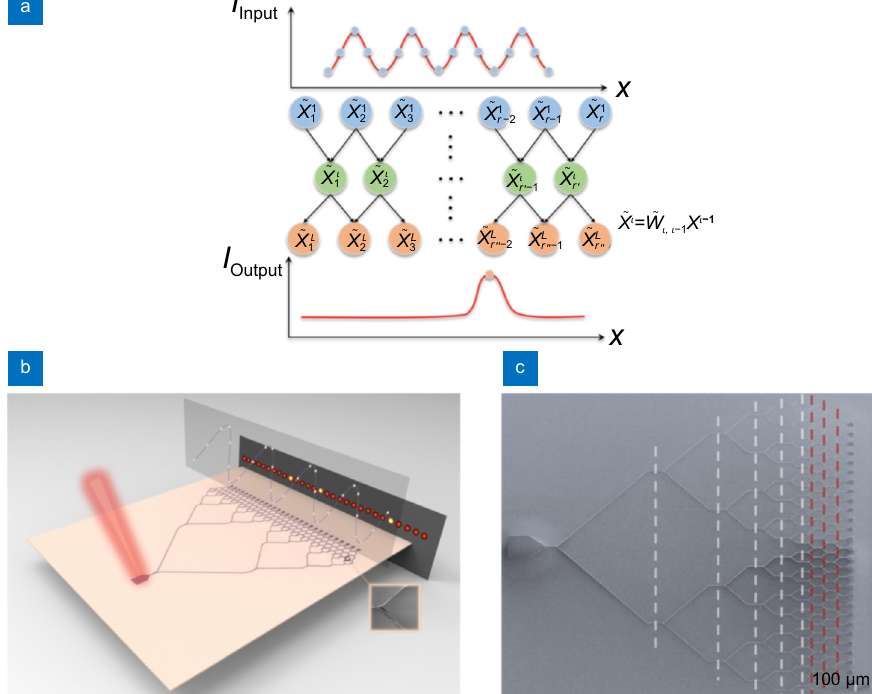
Fig. 1 | General architecture of the all-optical computing framework. ( a ) The CNN architecture showing the connections between adjacent layers: , where and represent the l th and ( l −1) th layer’s optical signal respectively, shows the weight that determines how signals are propagated from l th layer to ( l −1) th layer. ( b ) Schematic diagram of the all-optical transcendental equation solver. ( c ) Top-view SEM image of the all-optical transcendental equation solver, where the scale bar is 100 μm. Here, the white dotted lines mark the five layers for waveform discretization, and the red dotted lines separate the three layers of the optical CNN